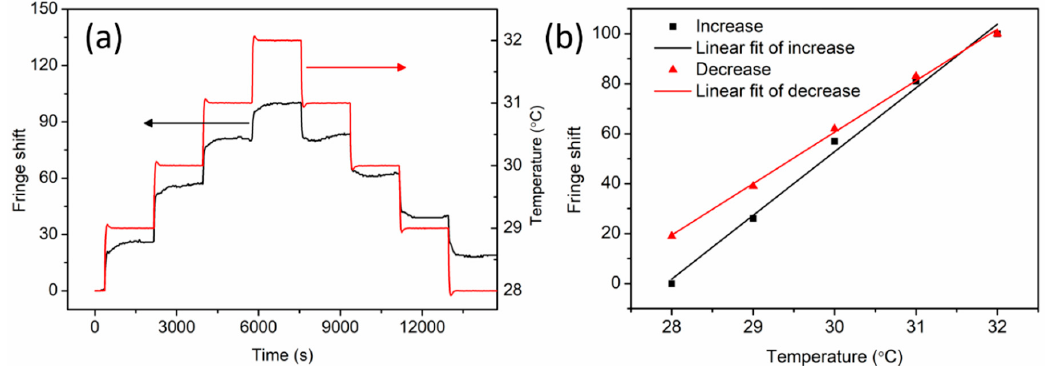
Figure 6. ( a ) Fringe and temperature variation as a function of time and ( b ) linear fit of fringe shift versus temperature (increase and decrease) for non-annealed PC mPOF.